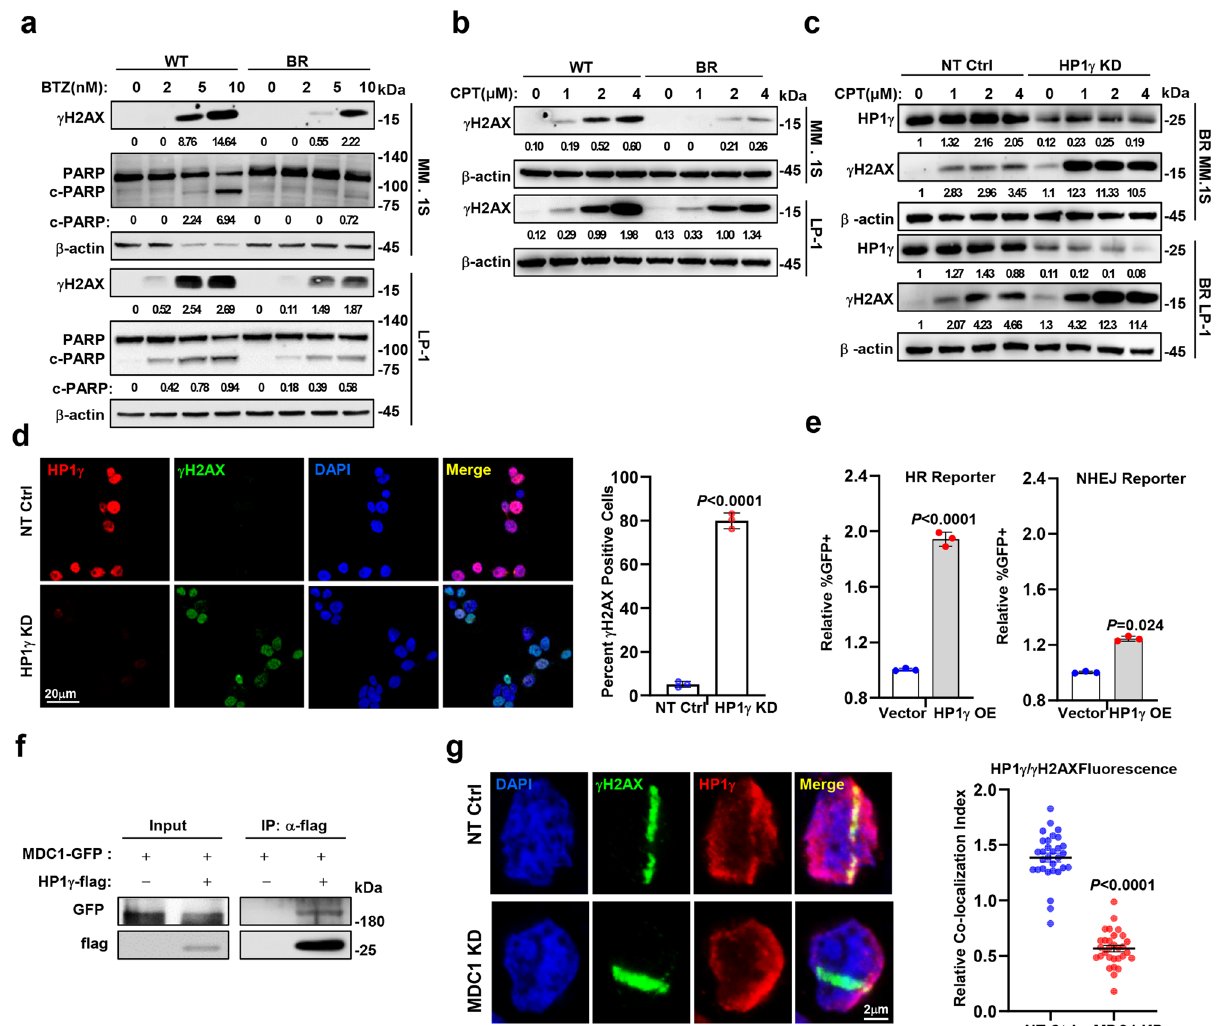
Fig. 3 | HP1 γ facilitates homologous recombination of DNA repair. a Western blottingshows γ H2AXandcleavedPARPinWTandBRMMcelltreatedwithBTZfor 24h. b Levels of γ H2AX in WT and BR MM cells treated with camptothecin (CPT, 0 – 4 μ M)for24h. c Westernblottingshows γ H2AXinMMcellswithHP1 γ KDtreated with gradient concentration CPT for 4h. d Left: immuno fl uorescence assay shows the level of γ H2AX in WT and BR MM cells treated with CPT (2 μ M) for 4h. Right: quanti fi cationof γ H2AXfoci.Atleast100cellswerecounted,and n =3independent experiments. Data represent mean±S.E.M., student ’ s t test. e Quantitative assess- ment of HRandNHEJ activitiesinHEK293Tcellsexpressing vector control or HP1 γ